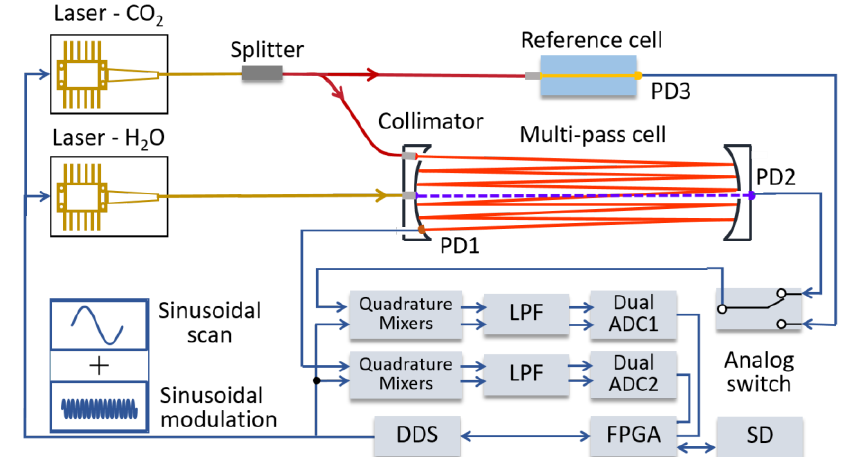
Figure 2. Diagram of the scanned-wavelength WMS- θ 1f based CO 2 and H 2 O detection system, which consists of an open-path multi-pass cell and a reference gas cell for regular CO 2 auto-calibration. The field-programmable gate array-based (FPGA) lock-in detection used a direct digital synthesizer (DDS) to generate scanned-modulation laser driver current, demodulate the 1f signal, calculate the gases concentration and store measurement results to a SD memory card. WMS, wavelength modulation